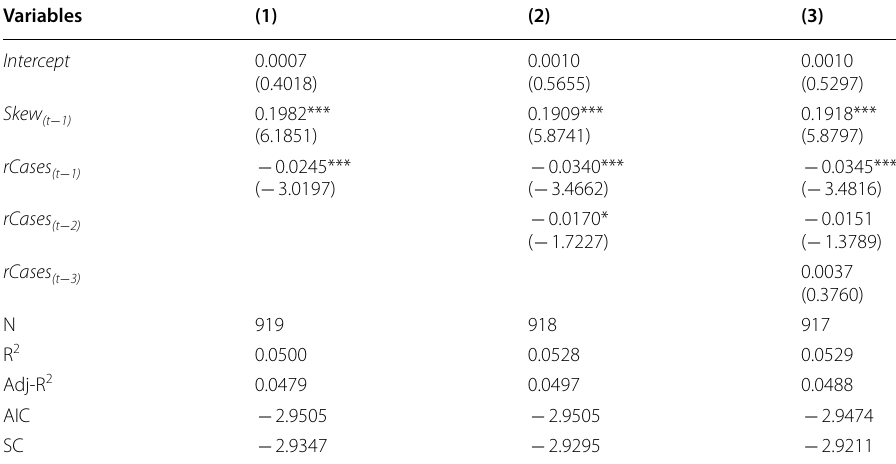
*** , **, * represent statistical significance at 1%, 5%, and 10% levels, respectively. The t‑statistics are presented in the brackets